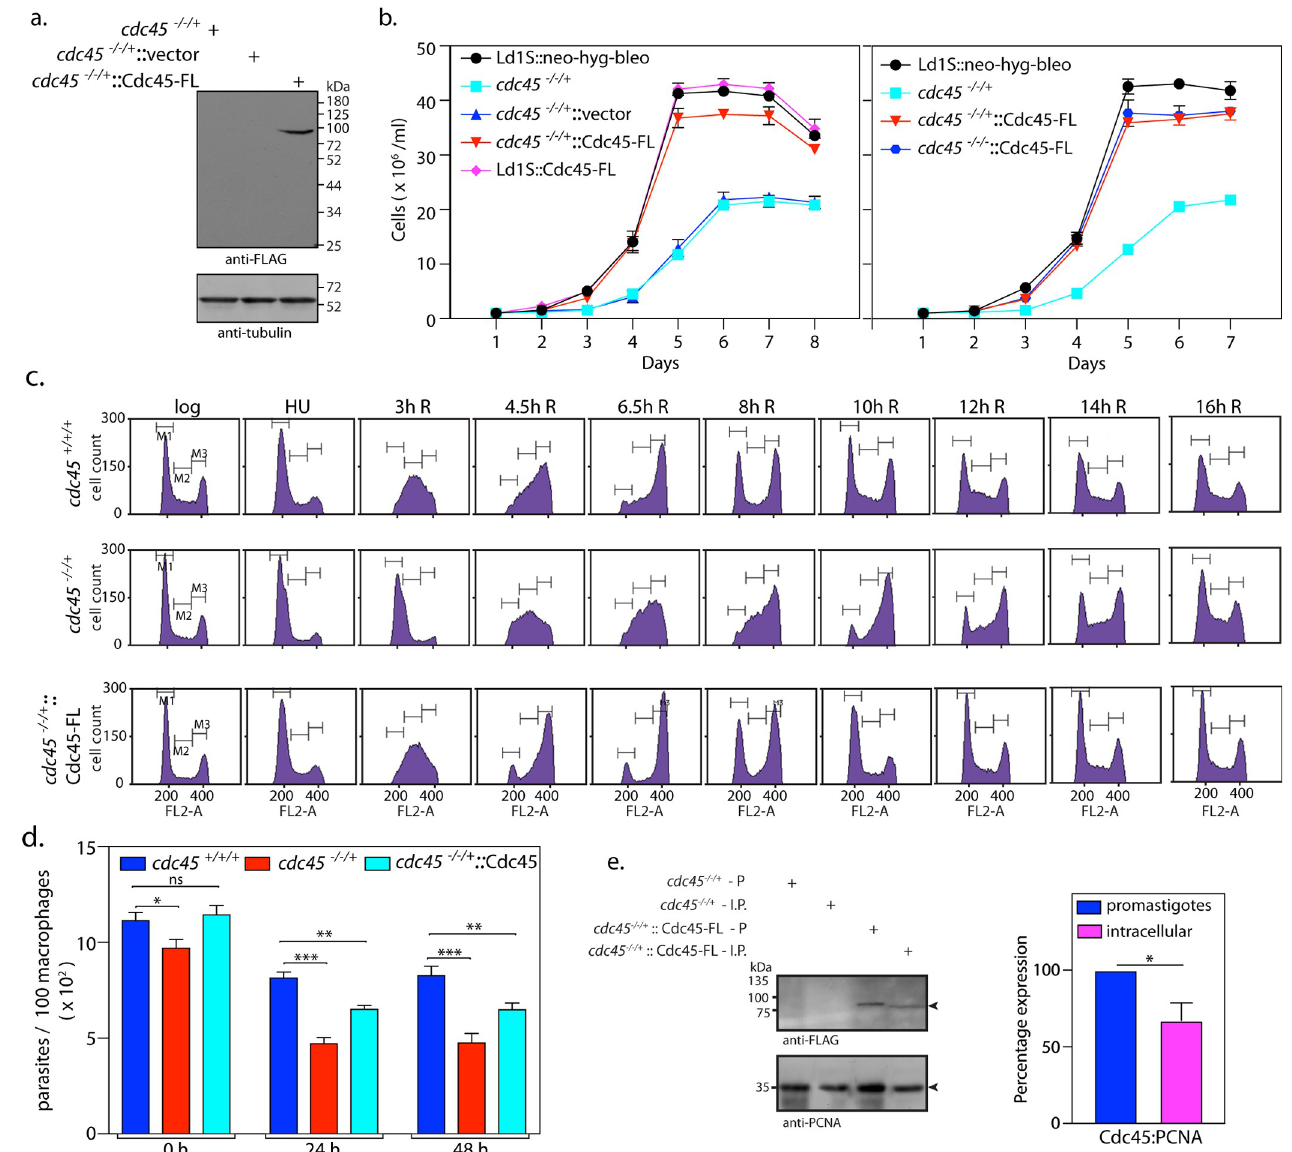
Fig 2. Ectopic expression of Cdc45 in cdc45 -/-/+ cells allows the cells to overcome defects associated with Cdc45 depletion. a. Western blot analysis of cell extracts using anti-FLAG antibody (Sigma, 1:1000 dil). cdc45 -/-/+ /vector- cdc45 -/-/+ cells harboring pXG-FLAG(bleo) vector. cdc45 -/-/+ ::Cdc45-FL— cdc45 -/-/+ cells harboring pXG-Cdc45-FLAG(bleo) i.e. the rescue line. Loading control: tubulin. b. Left panel: Analysis of growth pattern of rescue line cdc45 -/-/+ :: Cdc45-FL in comparison with cdc45 -/-/+ cells and control cells (Ld1S::neo-hyg-bleo—Ld1S::neo-hyg cells harboring pXG-FLAG ( bleo ) empty vector). Right panel: Analysis of growth pattern of line cdc45 -/-/- ::Cdc45-FL in comparison with cdc45 -/-/+ ::Cdc45-FL cells and cdc45 -/-/+ cells. Growth was initiated at 1x10 6 cells/ml from stationary phase cells. Graphs represent average values of three experiments, with error bars representing standard deviation. c. Flow cytometry analysis of rescue line cdc45 -/-/+ ::Cdc45-FL in comparison with cdc45 -/-/+ cells and cdc45 +/+/+ control cells (Ld1S::neo-hyg-bleo cells). 30000 events counted in every sampling. Sampling times indicated above the histograms. Cells representing G1, S and G2/M phases indicated by gates M1, M2, M3. Experiment done thrice, one data set depicted here. d. Analysis of cell survival within host macrophages. cdc45 +/+/+ control cells—Ld1S::neo-hyg-bleo cells. Intracellular parasites were scored by Z-stack imaging of DAPI-stained infected macrophages using confocal microscopy. Bar chart depicts averages of three experiments; error bars indicate standard deviation. Two-tailed student’s t-test was applied: �� p < 0.005; ��� p < 0.0005; ns-not significant. e. Left panel: Western blot analysis of extracts isolated from promastigotes (P) and intracellular parasites (I.P.) expressing Cdc45-FLAG. As the Leishmania PCNA antibody does not cross-react with mouse PCNA (which is also of lower molecular weight) it was used as the loading control to ensure comparable loading of parasite total protein. The experiment was done thrice. Right panel: quantification of Cdc45 using Leishmania PCNA as internal control, using ImageJ software. Average of three experiments is shown, with error bars indicating standard deviation. Student’s t-test was applied: � p < 0.05.